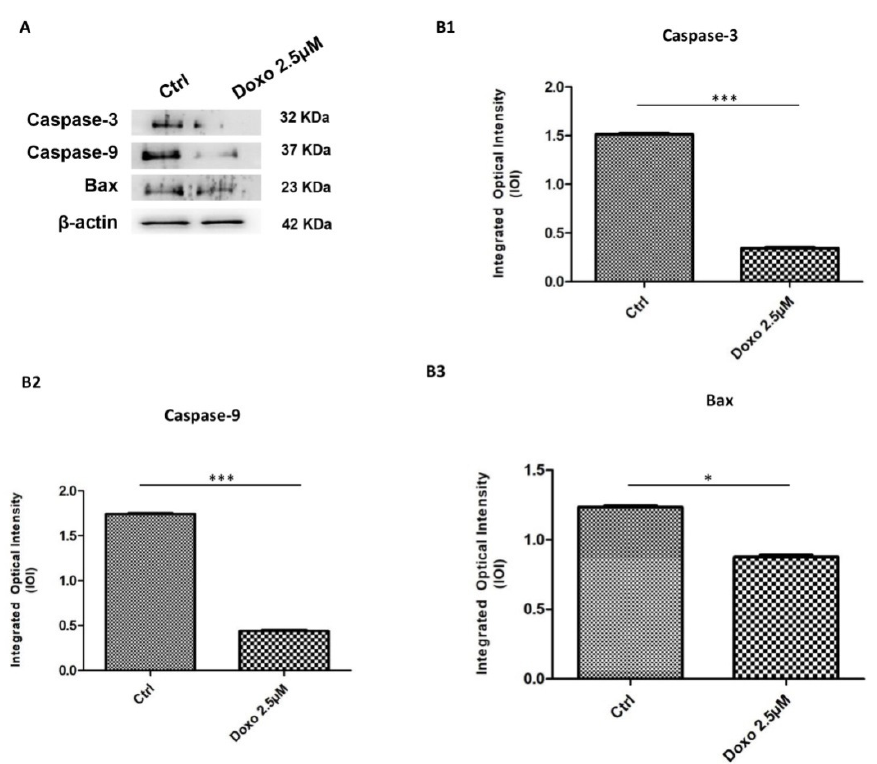
Figure 7. Western blotting analysis of apoptosis related markers. ( A ) Caspase-3, caspase-9 and Bax proteins expression in Cal-27 cell line untreated and treated with 2.5 µ M Doxo. Each membrane was probed with β -actin antibody to verify loading consistency. Western blot data shown are the representative data from three different experiments. ( B1 – B3 ) Histograms represent densitometric measurements of proteins bands expressed as integrated optical intensity (IOI) mean of three separate experiments. The error bars show standard deviation ( ± SD). Densitometric values analyzed by t -test (unpaired t -test) return significant differences. *** p < 0.001, * p < 0.05.